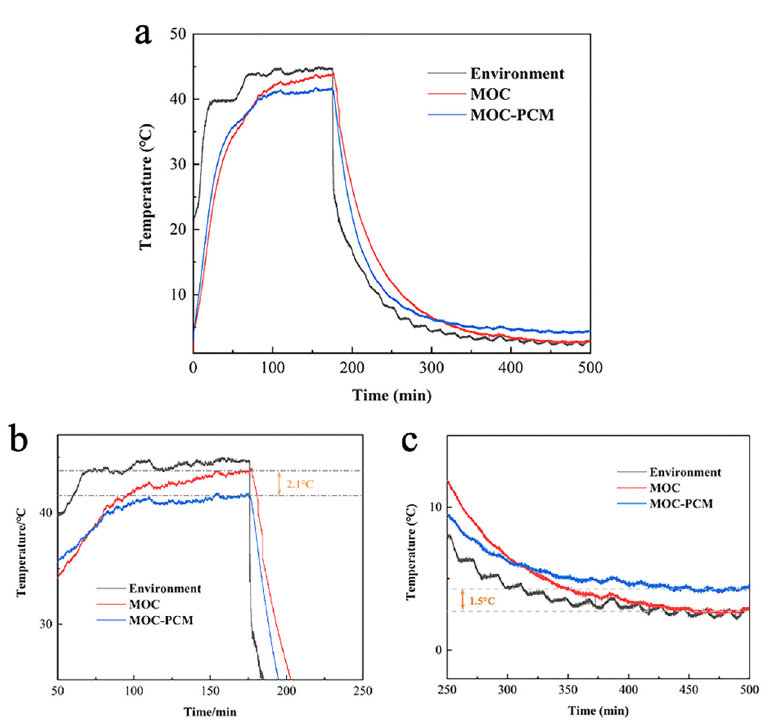
Figure 8. ( a ) Thermal performance comparison between MOC and MOC-PCM; ( b ) Enlarged view after heating; ( c ) Enlarged view after cooling down.